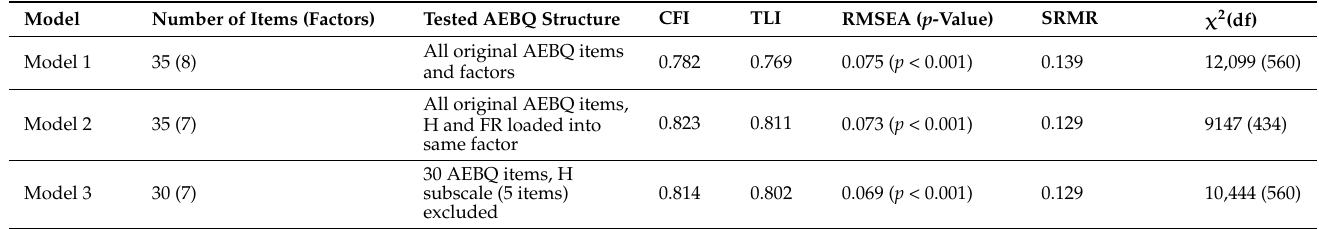
Table 2. Goodness of fit statistics of three models from a confirmatory factor analysis of the AEBQ, among Portuguese